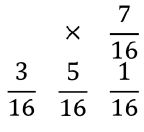
Figure 3. Example of Floyd-Steinberg error kernel.